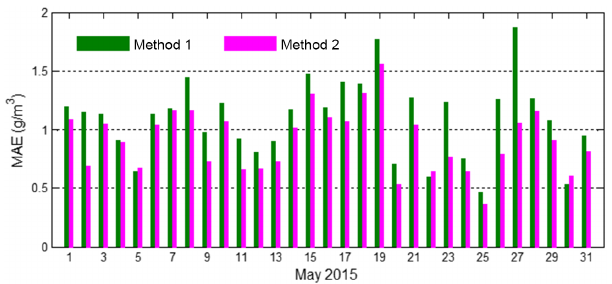
Figure 11. MAE comparison of two methods from 1 to 31 May